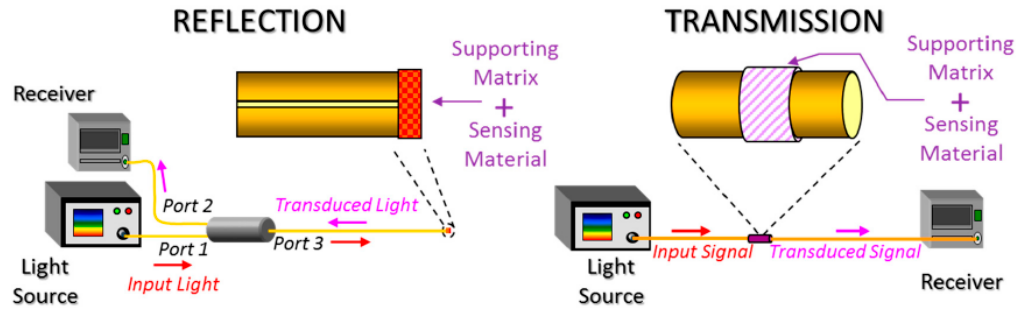
Figure 1. Schematic representation of two different architectures used for optical fiber sensors such as reflection mode ( left ) and transmission mode ( right ). Reprinted with permission of [16].